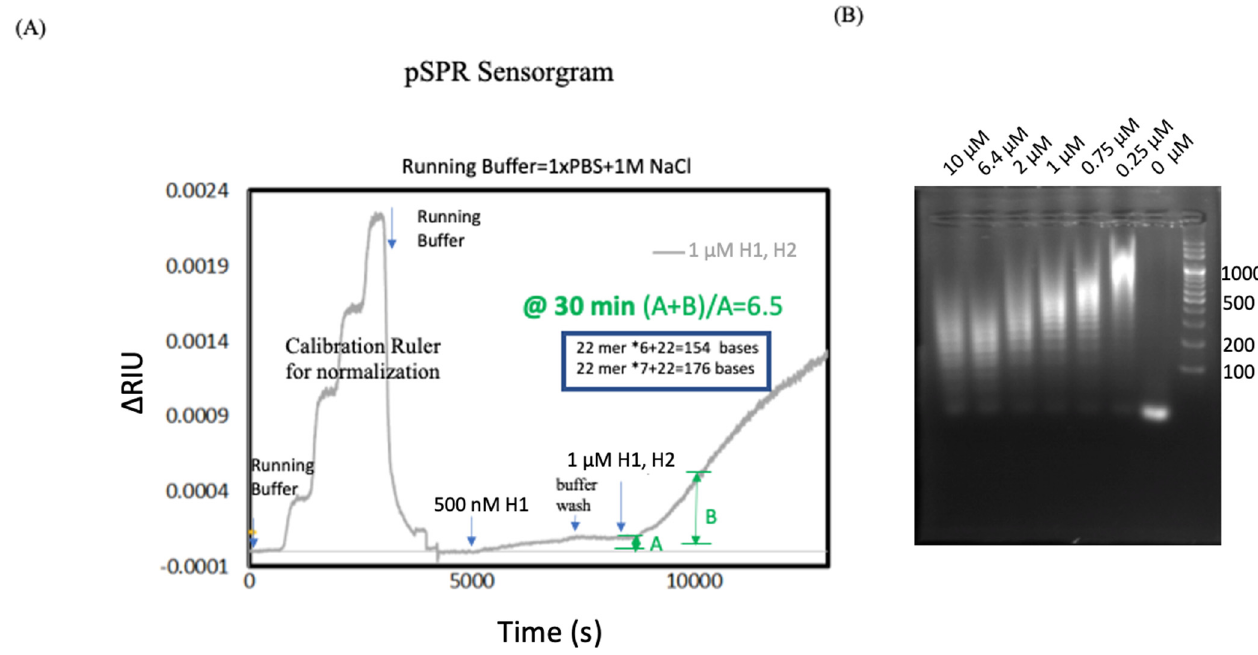
Figure 4. ( A ) Real-time detection of the HCR reaction. In the pSPR result, after 30 min of the initiator and H1 binding reaction and the 30 min washing step marks A, the time point of 30 min after the addition of the H1 and H2 mixture marks B. (A + B)/A = 6.5, indicating a 6.5-fold of the detection measure at 30 min. ( B ) Combining pSPR and DNA gel electrophoresis results. The length of the HCR complex at the same reaction time, 30 min, can be observed.